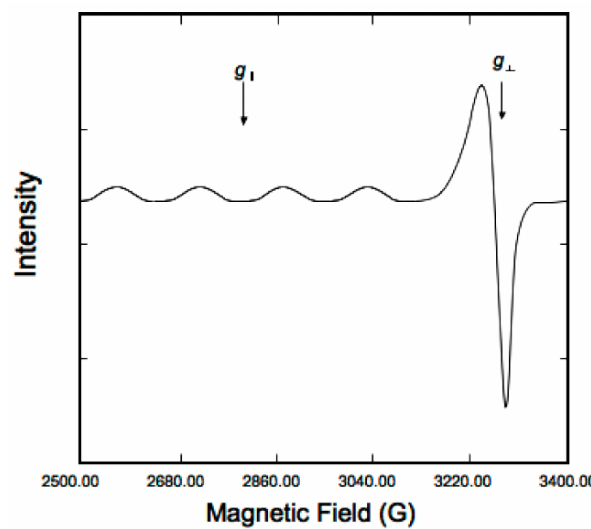
Figure 8. Typical X-band EPR spectrum of copper(II) compounds